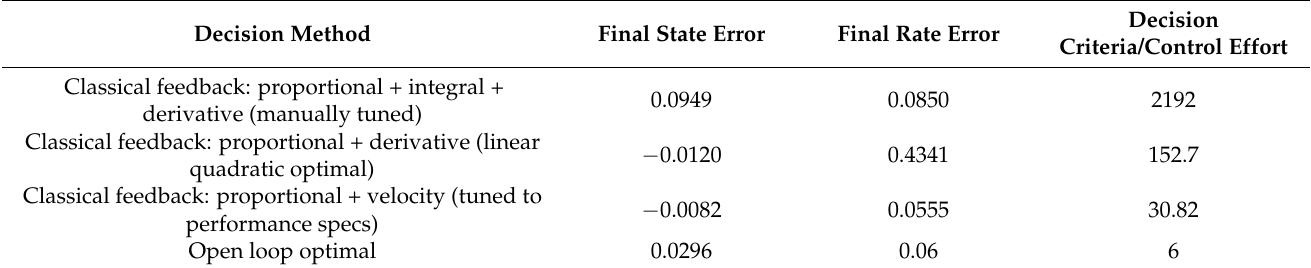
Figure 6. Comparison of classical methods with scaled time on the abscissae and respective ordinates titled in the subplot captions: thinner solid blue line is manually tuned PID, dashed line is linear quadratic optimal PD, dotted line is proportional plus velocity tuned to performance specification, thicker solid black line is open loop optimal per Pontryagin (Equation (31) provided for anticipated comparison). ( a ) States, ( b ) rates, and ( c ) decision criteria). Notice the solid black line representing the optimal open loop solution in subfigure ( c ) is initially positive to create movement in the desired direction, and the control switches exactly at the halfway point to a negative input, slowing progress towards the final desired end states (position and rate states). The ranges of the zoomed view in the inset are indicated by the respective scales. Table 2. Comparison of classical decision methods.